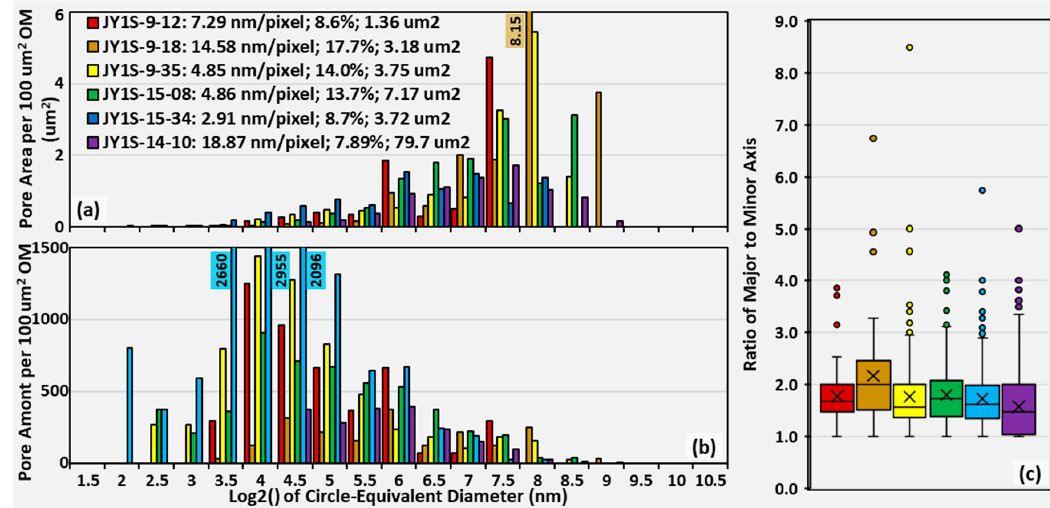
Figure 7. The pore size distribution (PSD) and geometry of OM-hosted pores within the second subtype of weakly or undeformed porous pyrobitumen (OM II) of Longmaxi-Wufeng Shale, Eastern Sichuan Basin. ( a ) PSD determined by pore sectional area; ( b ) PSD determined by pore amount; and ( c ) ratio of the major to minor axis. The three values after image ID in the legend are image resolution (nm / pixel), organic porosity (%), and OM sectional area ( µ m 2 ). The number labels show the values that are beyond the range of the vertical axis.